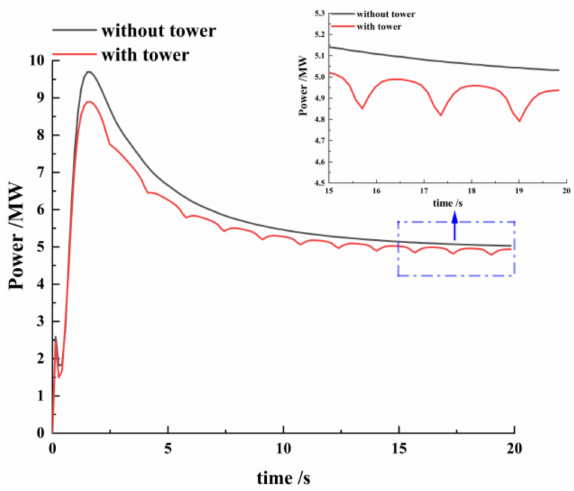
Figure 5. Power variation under unsteady rated